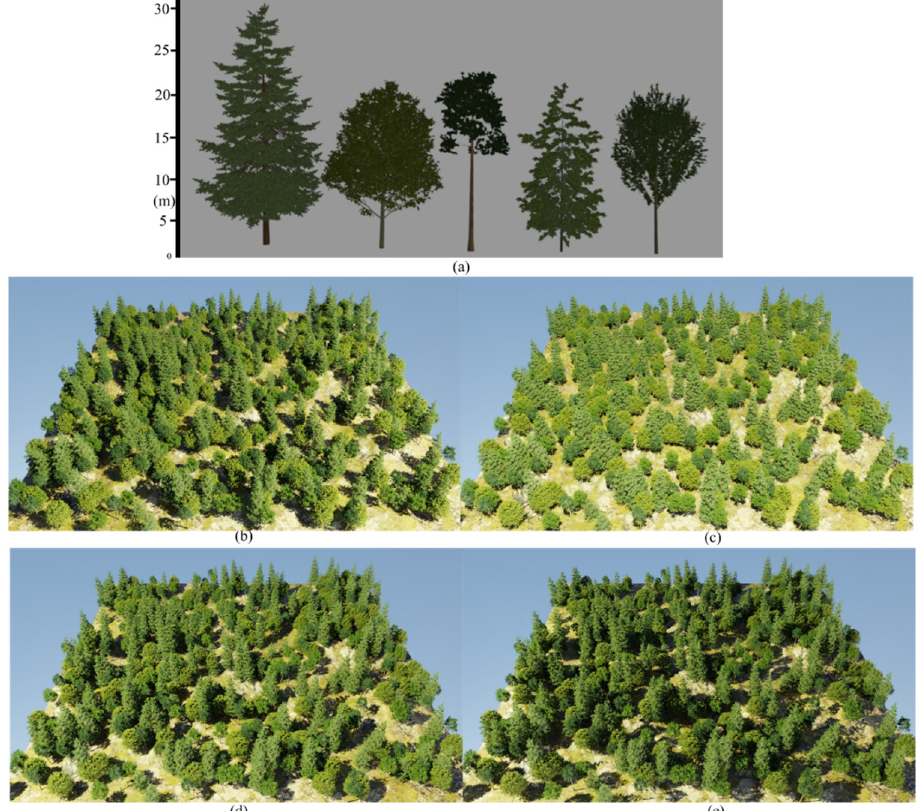
Figure 8. Light simulation of mixed tree species plot composed of five species in ( a ). ( a ) Exemplary three ‐ dimensional models of five tree species built in the SpeedTree software. From left to right: Douglas fir, European beech, Scots pine, Norway spruce, and European ash. ( b – e ) Light simulation results of mixed tree species plot at different times on 10 September 2022 in Nanjing: ( b ) at 10:00, ( c ) at 12:00, ( d ) at 14:00, and ( e ) at 16:00. Table 5. Light transmittance of five tree species in the emulated mixed plot at different times with corresponding solar azimuth angle a and altitude angle l , i.e., 10:00 ( a : 133.91°; l : 46.61°), 12:00 ( a : 180.57°; l : 57.01°), 14:00 ( a : 226.74°; l : 46.17°), and 16:00 ( a : 251.79°; l : 23.96°), on 10 Septem ‐ ber 2022 in Nanjing.